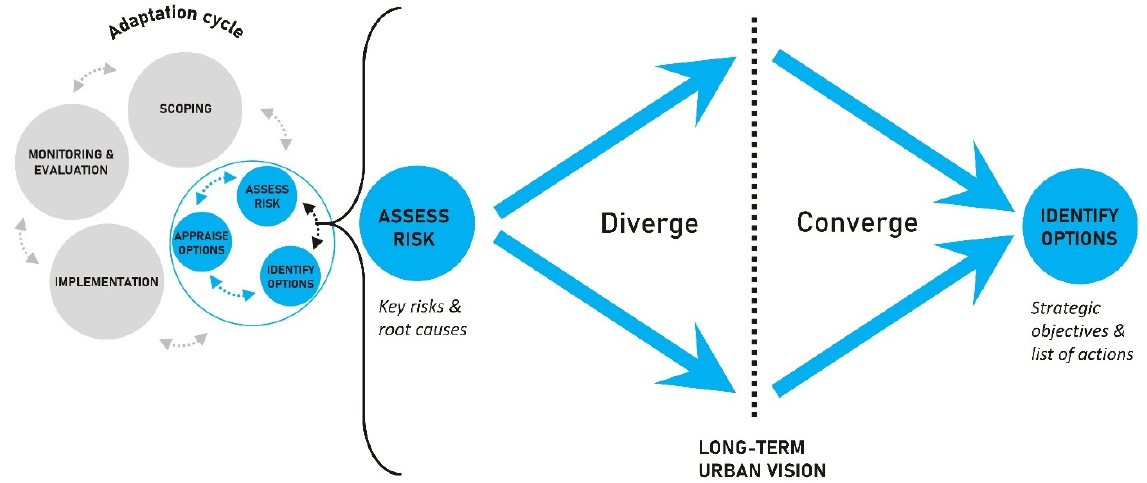
Figure 4. Visioning urban development, integrating social, ecological, and economic opportunities with resilience to climate change. Adding to the classic adaptation management cycle, an additional step is proposed in which long-term urban visions are created that consider social, environmental, and economic opportunities and desires. This step is introduced after the assessment of risks, but before moving to specific solutions or actions. In all steps (risk assessment, vision creation, choice, and design of specific solutions), a broad range of stakeholders should be engaged.